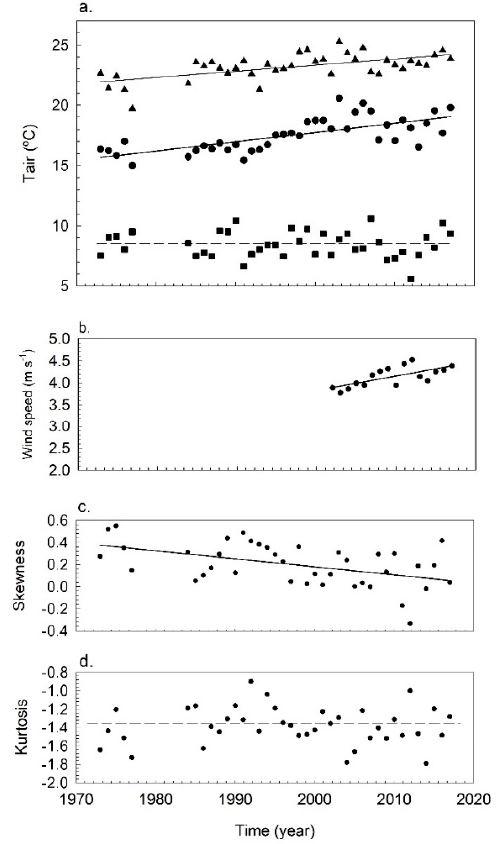
Figure 2. Temporal evolution of the air temperature for the July, August and September (JAS) period (solid triangles), the March, April and May (MAM) period (solid circles) and December, January and February (DJF) period (solid squares) ( a ), temporal evolution of the mean wind speed (in m s − 1 ) averaged over the March, April and May (MAM) period ( b ), temporal evolution of the skewness of the air temperature distribution for the period 1973–2018 ( c ) and temporal evolution of the kurtosis for the air temperature distribution for the period 1973–2018 ( d ).